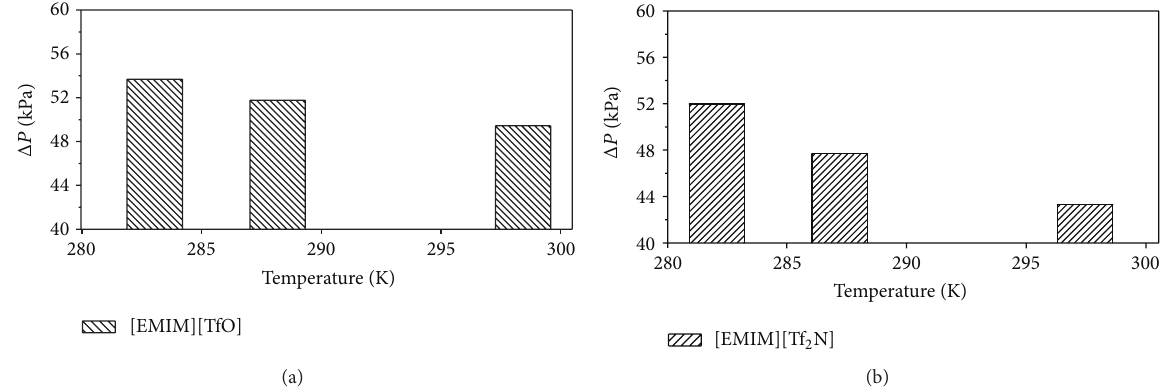
Figure 5: Maximum transmembrane pressure obtained for PP support in different temperatures.